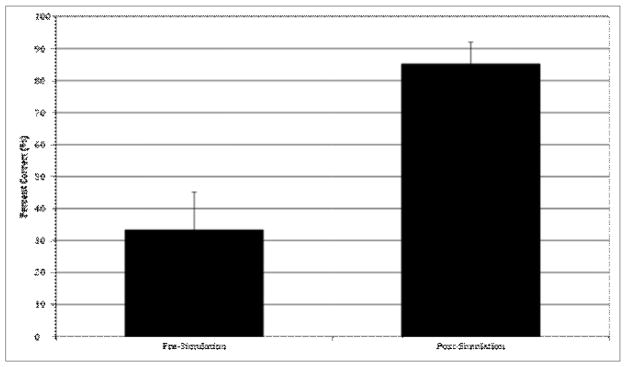
Overall resident performance on anatomical test performance pre (33.33 ± 11.83) and post (85.19 ± 6.83) simulation (n = 6 otolaryngology residents). Data presented as mean ± SEM